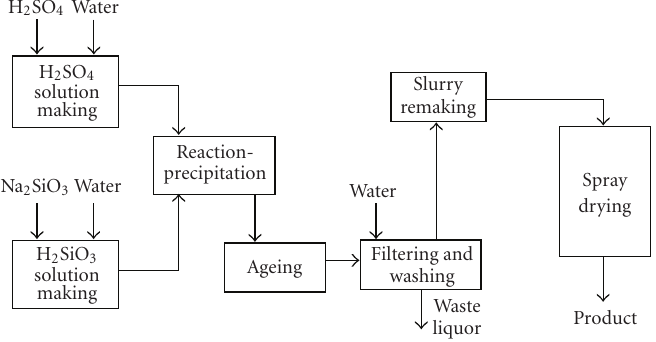
Figure 11: Principle system scheme of pilot plant test for preparation of “ultrafine” white carbon black by impinging stream reaction −